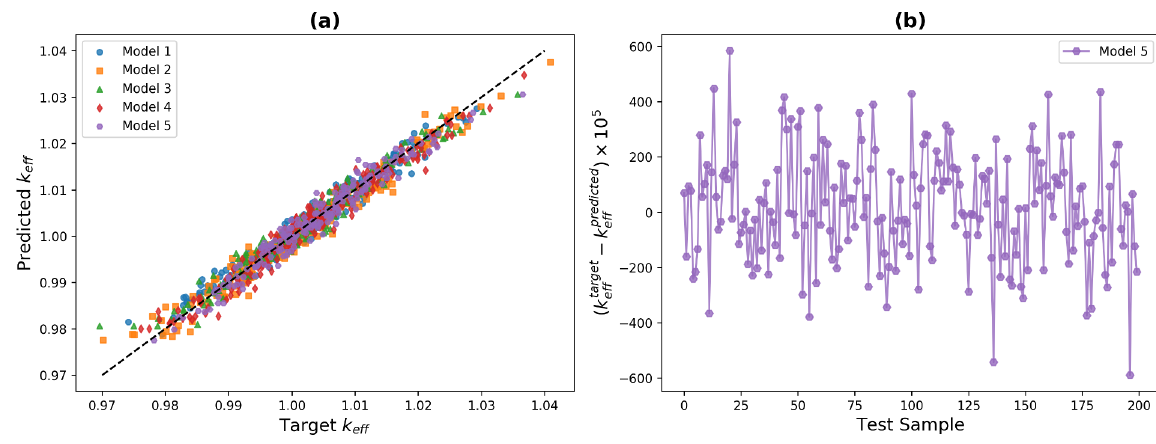
Figure 3: (a) k target versus DNN prediction based on the test samples of all five models, eff (b) pcm difference between target and prediction for 200 test samples of Model